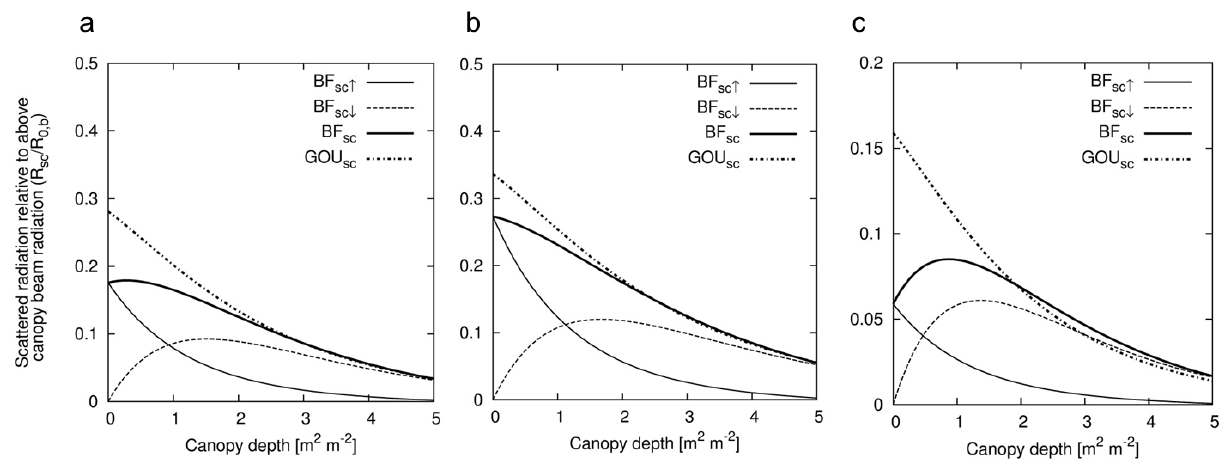
Fig. 2. The modeled profiles of scattered radiation ( R sc ) in the broadband (a) , near infra red (b) and photosynthetically active radiation spectra (c) relative incoming beam radiation ( R 0,b ) for the respective models. Note the difference in scale between (a–b) and (c) . For the BF model, scattering (thick solid line) is divided into upwelling (BF sc ↑ : thin solid line) and downwelling scattered radiation (BF sc ↓ : dashed line). For the GOU model total scattered radiation is simulated (GOU sc : dotted/dashed line) using scattering equal to the sum of transmittance ( t = 0 . 22) and reflectance ( r = 0 . 30). For the BF model scattered radiation (BF sc : thick solid line) is the sum of BF sc ↓ and BF sc ↑ .